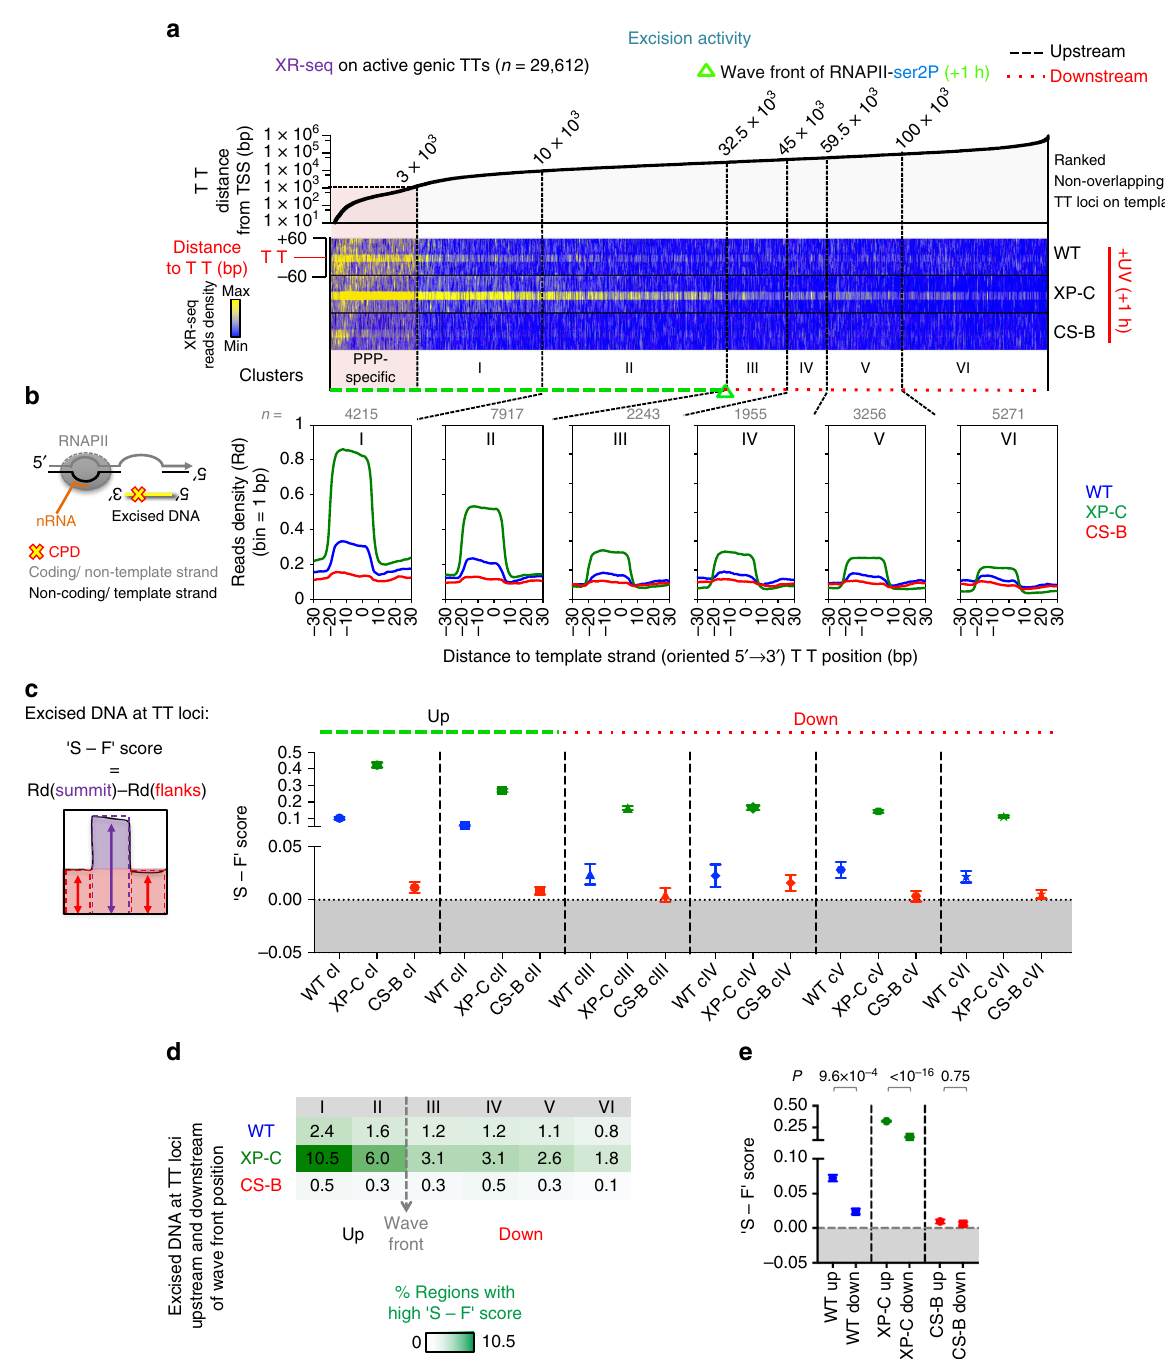
Fig. 5 NER of DNA lesions is enhanced by the de novo wave-release of RNAPII upon genotoxic stress. a Heatmaps illustrating the distribution of excised DNA fragments representative of repair activity at 1 h of recovery in cell lines pro fi cient for TC-NER activity (WT, XP-C), or not (CS-B) (reads from XR-seq study 36 ) (see Methods for details). XR-seq reads were aligned around TT loci localised in active genes (Supplementary Fig. 8a) and sorted from left to right by increasing distances relative to TSS. TT loci were clustered (Upstream; clusters I and II, or Downstream; clusters III – VI) relatively to RNAPII-ser2P wave front position at +1 h of recovery (as in Fig. 4a). TT loci near PPP-speci fi c RNAPII signal were not considered for analysis. b Average plots of Read densities (Rd) mapped in a for individual clusters ( n is indicated). c Plot showing the average ( ± SEM) of the difference between Rd at summit and Rd at fl anks ( ‘ S - F ’ score) of all regions analysed in b ( P -value based on two-sided Wilcoxon rank-sum test). d Heatmap representing the proportion of regions (per cluster) with high ‘ S - F ’ scores ( > threshold = average ‘ S - F ’ + 3 × SD, as calculated for the control exon start regions, see Methods). e Plot showing the comparison of average ( ± SEM) ‘ S - F ’ score for all regions upstream (Up) and downstream (Down) of the respective wave front position, for each cell line ( P -value based on two-sided Wilcoxon rank-sum test using BH adjustment)